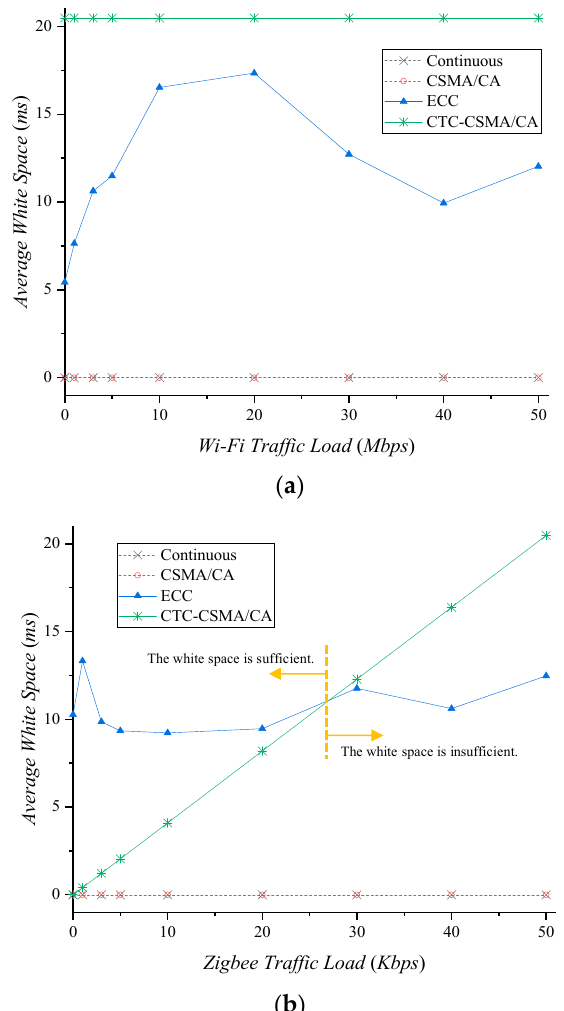
Figure 8. Average white space according to traffic load. ( a ) Wi − Fi traffic load, ( b ) Zigbee traffic load.